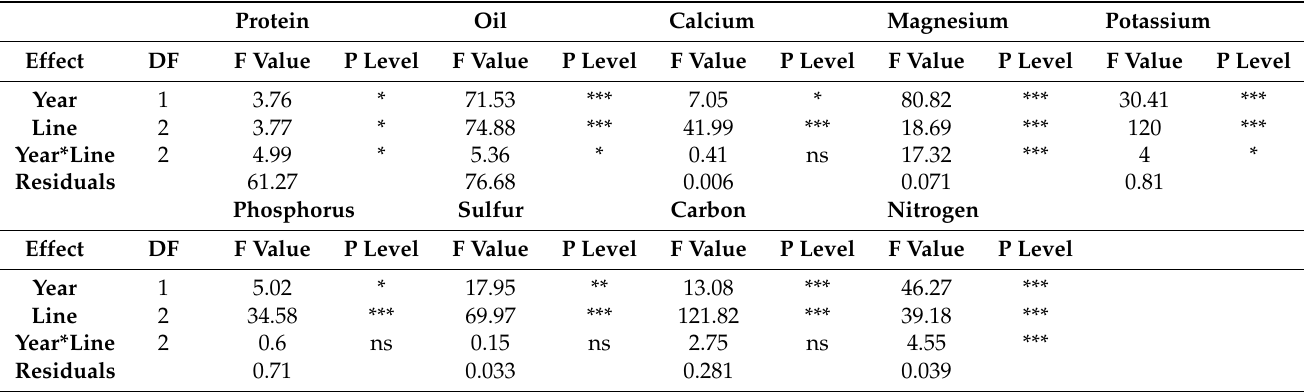
Table 1. Analysis of variance (F and P values) for the effect of leaf shape trait (curly leaf) on cottonseed protein and oil (g/kg); calcium (Ca), magnesium (Mg), potassium (K), phosphorus (P), sulfur (S) (mg/g); carbon (C), and nitrogen (N) (%). The experiment was conducted in 2014 and 2015 in Stoneville, MS, USA.